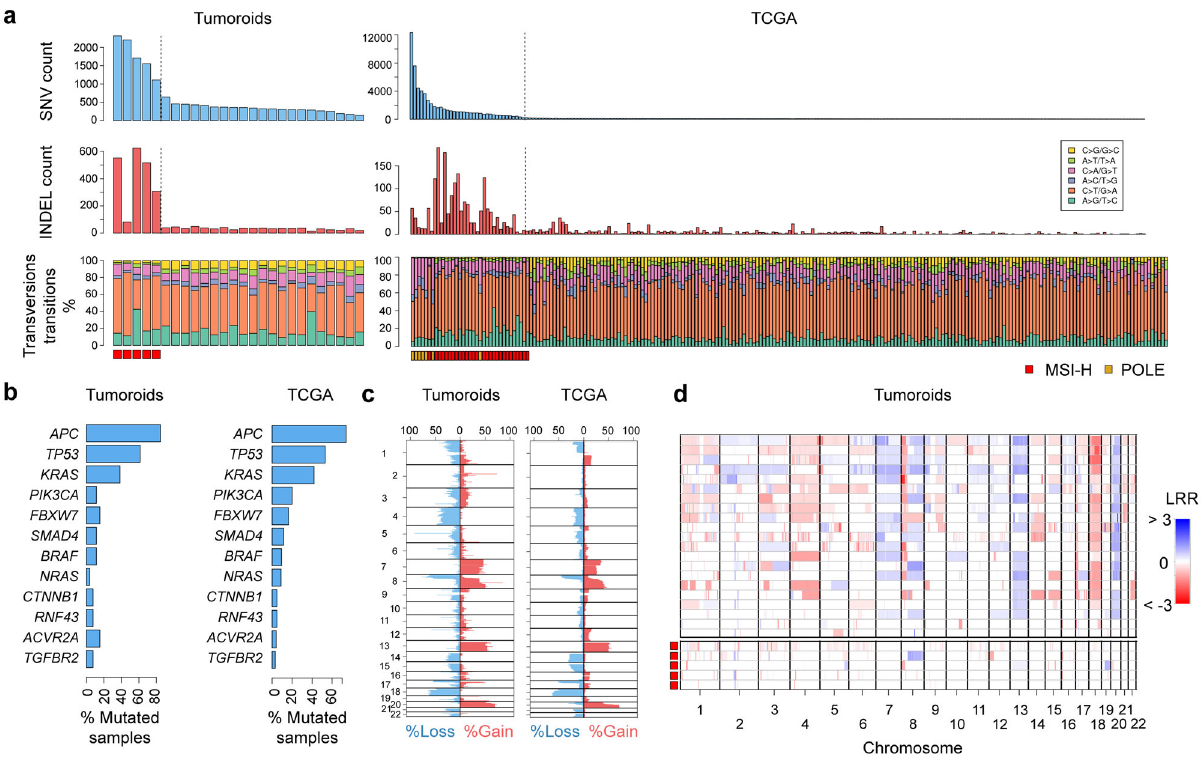
Fig. 5 Global genomic alterations in human colorectal tumoroids. a Mutation pro fi les in 26 colorectal tumoroids and 224 TCGA colorectal cancers. Counts of SNVs and InDels, and proportions of nucleotide transitions and transversions are reported, split into distinct hypermutated and nonhypermutated cases. b Mutation frequencies of major colorectal cancer driver genes for tumoroids and TCGA-analyzed cancers. c Proportions of samples with relative DNA copy-number alterations for tumoroids and TCGA-analyzed cancers. d Genome-wide DNA copy-number aberrations for tumoroids strati fi ed into nonhypermutated and hypermutated (MSI-H)